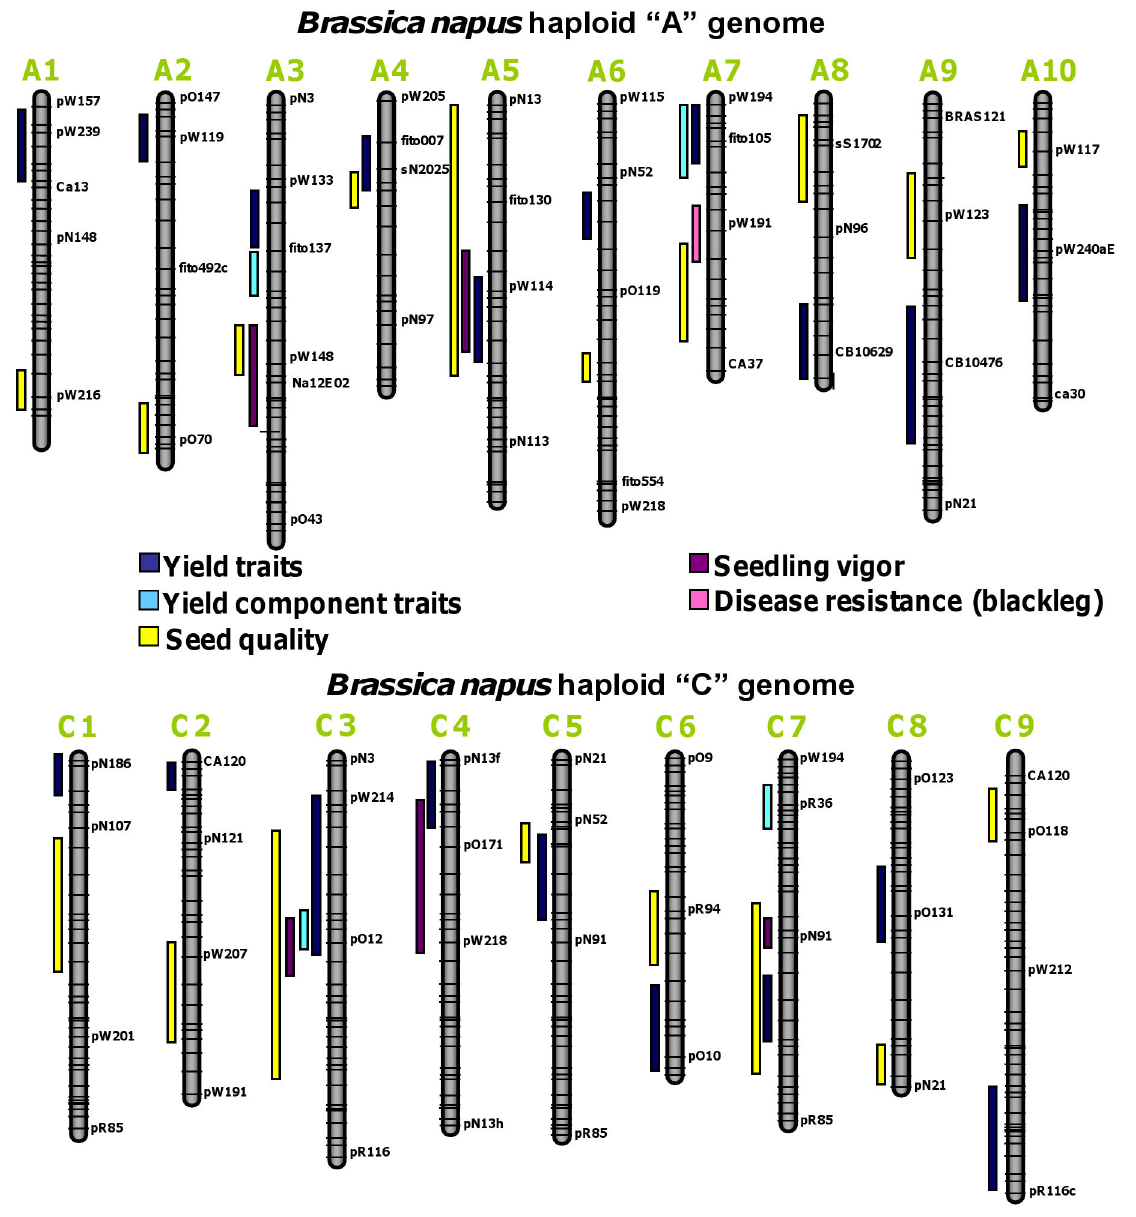
Figure 1. Selected genomic regions underlying traits of agronomical and nutritional interest in B. napus . Map integration was conducted according to common molecular markers and parental lines used in three different mapping studies [15,22,50]. QTL locations were inferred from relative map positions previously described [13,15,17-19,22] always using common sets of molecular markers and genetic